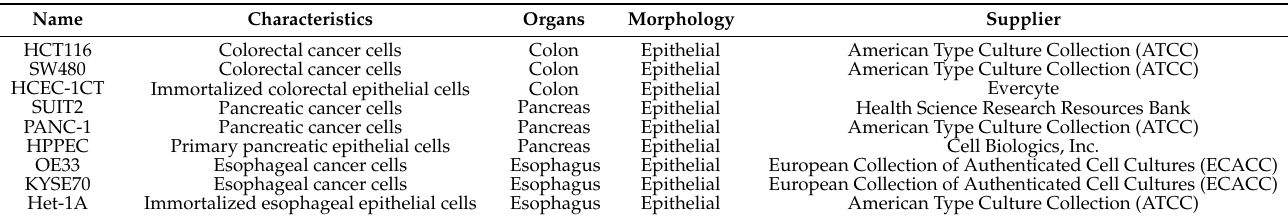
Table 1. Characteristics of each cell